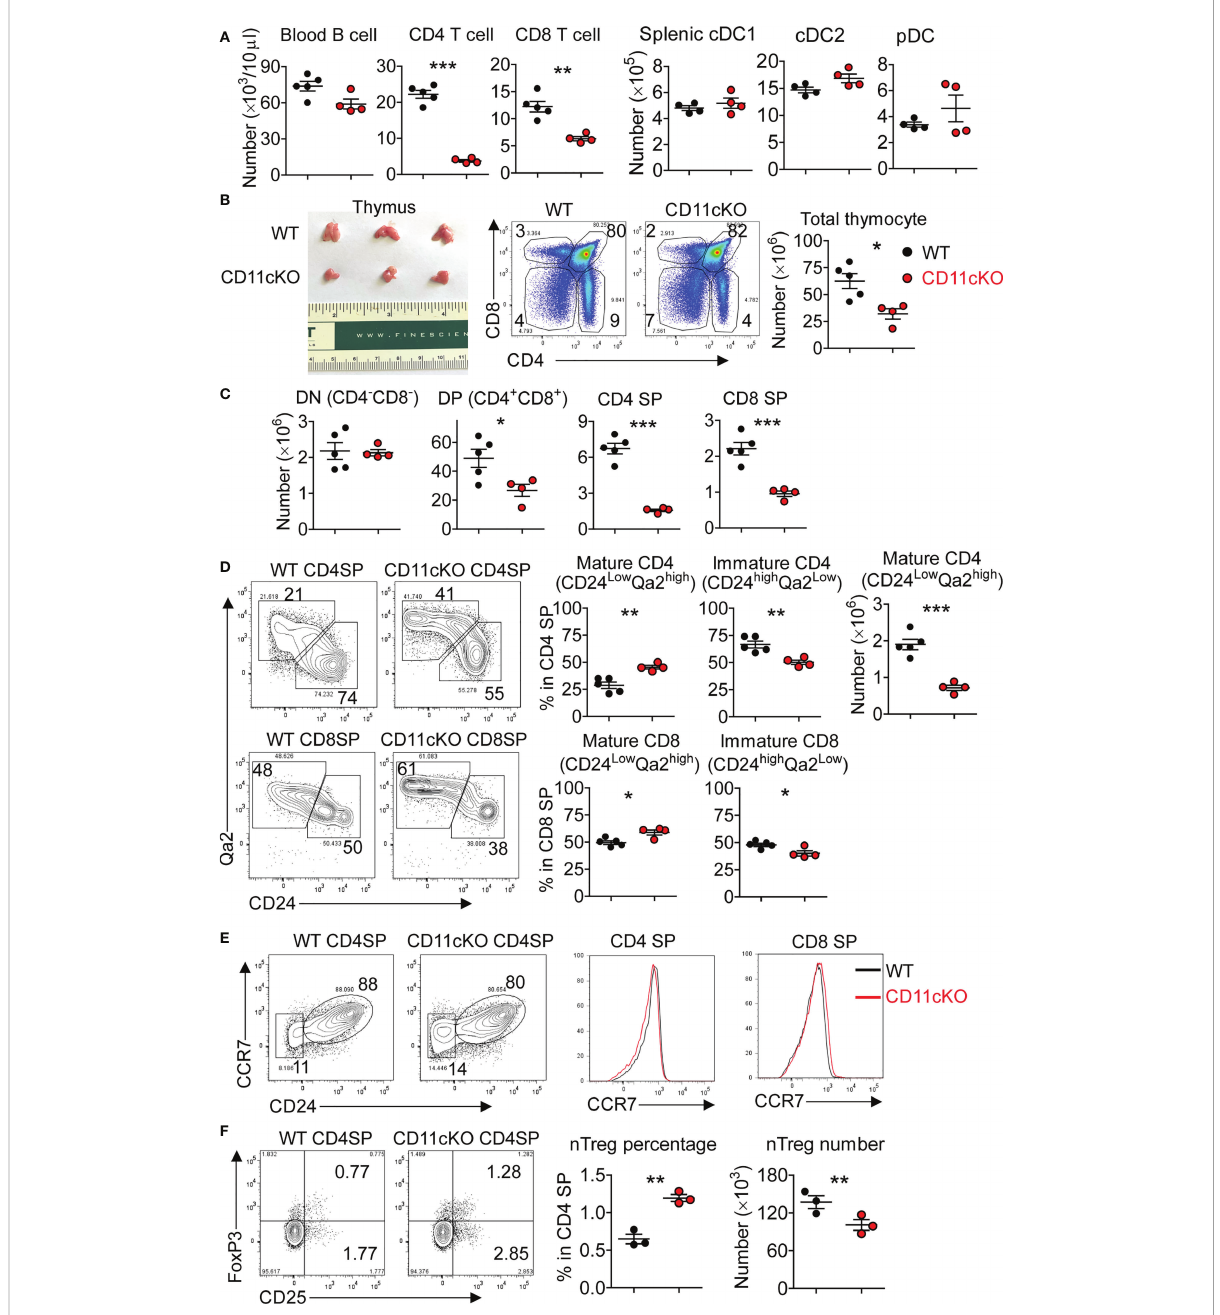
FIGURE 1 Thymic atrophy in CD11c KO mice. (A) Left: T and B cell counting in the peripheral blood in naïve WT and CD11c KO mice; Right: dendritic cell subset counting in the spleen. cDC1 was gated as MHC-II + XCR1 + CD8a + , cDC2 as MHC-II + XCR1 - CD8a - SIRP a + CD11b + , and pDC as PDCA + CD11b - Ly6C + . (B) Left: thymus image; Middle: representative FACS data, gated on total thymocytes of WT and CD11c KO mice; Right: dot plots of thymocyte number. (C) Thymic T cell subset numbers. DN was gated as CD4 - CD8 - , DP as CD4 + CD8 + , CD4 SP as CD4 + CD8 - , and CD8 SP as CD4 - CD8 + . (D) Left: representative FACS data showing maturation status of thymic CD4 SP and CD8 SP cells of WT and CD11c KO mice; Middle: dot plot showing percentage of immature and mature subsets in total CD4 and CD8 SP cells; Right: dot plot showing absolute number of mature CD4 SP cells; (E) Representative FACS data showing CCR7 expression on thymic CD4 SP and CD8 SP cells of WT and CD11c KO mice; (F) Left: representative FACS data showing natural regulatory T cells (nTreg) in thymic CD4 SP cells of WT and CD11c KO mice; Right: dot plots of both percentage and absolute number. nTreg cells were gated as CD25 + FoxP3 + CD4 + cells. Experiments were repeated at least 2-3 times with the same pattern. Student t test was performed for statistical analysis. *p < 0.05, **p < 0.01, ***p <